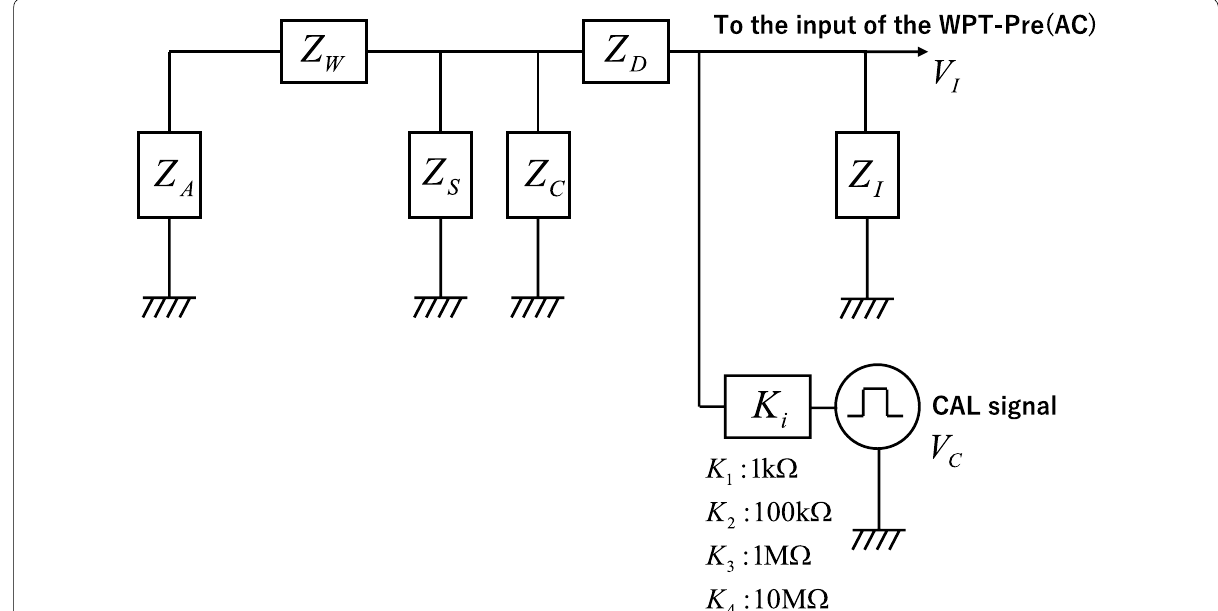
Fig. 14 Equivalent circuit of the calibration system for electric field